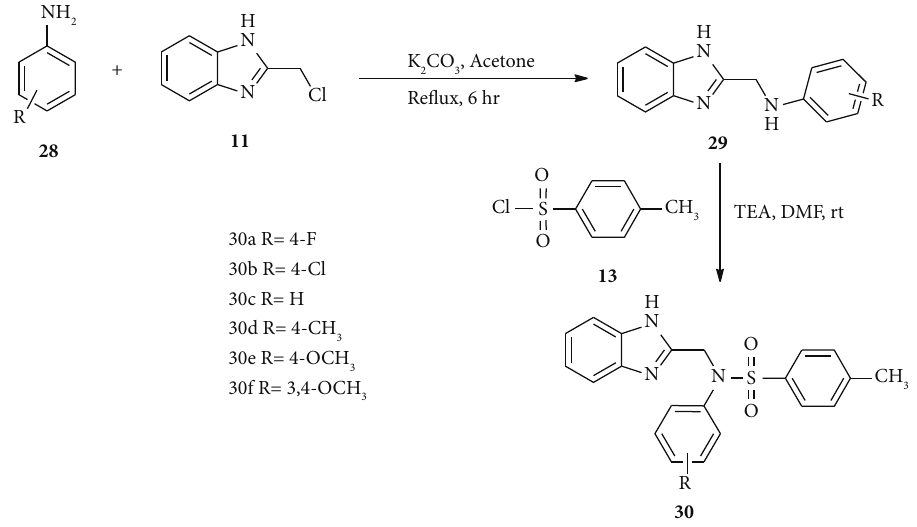
Scheme 5: Synthetic routes towards compound